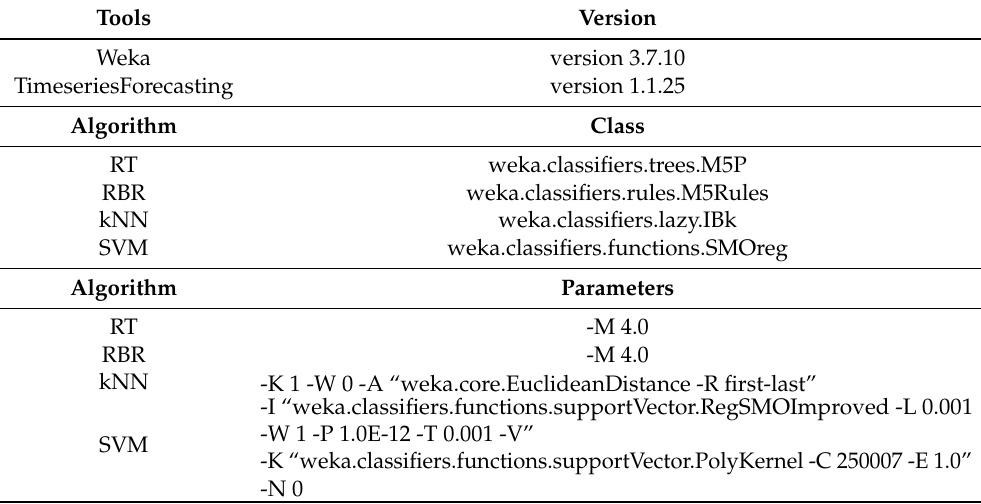
Table 1. Experimental tools and details.